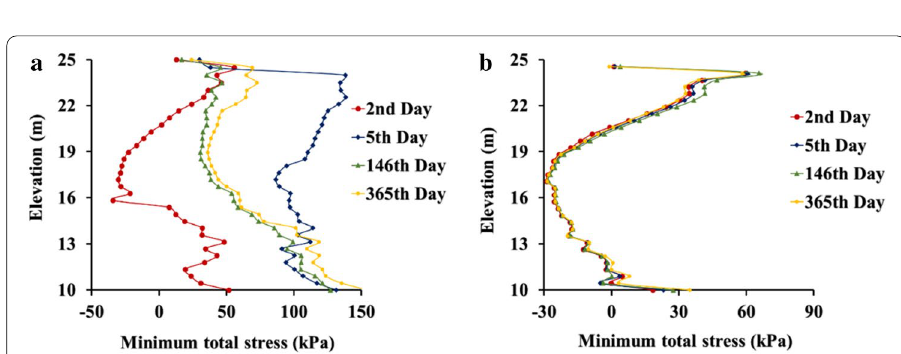
Fig. 12 Variation of minimum total stress in the earthen dam during and after the reservoir rise-up a upstream face, b downstream